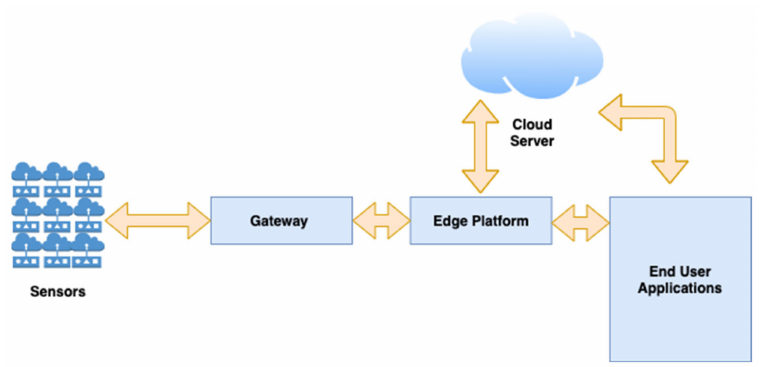
Figure 3. IoT architecture including the edge